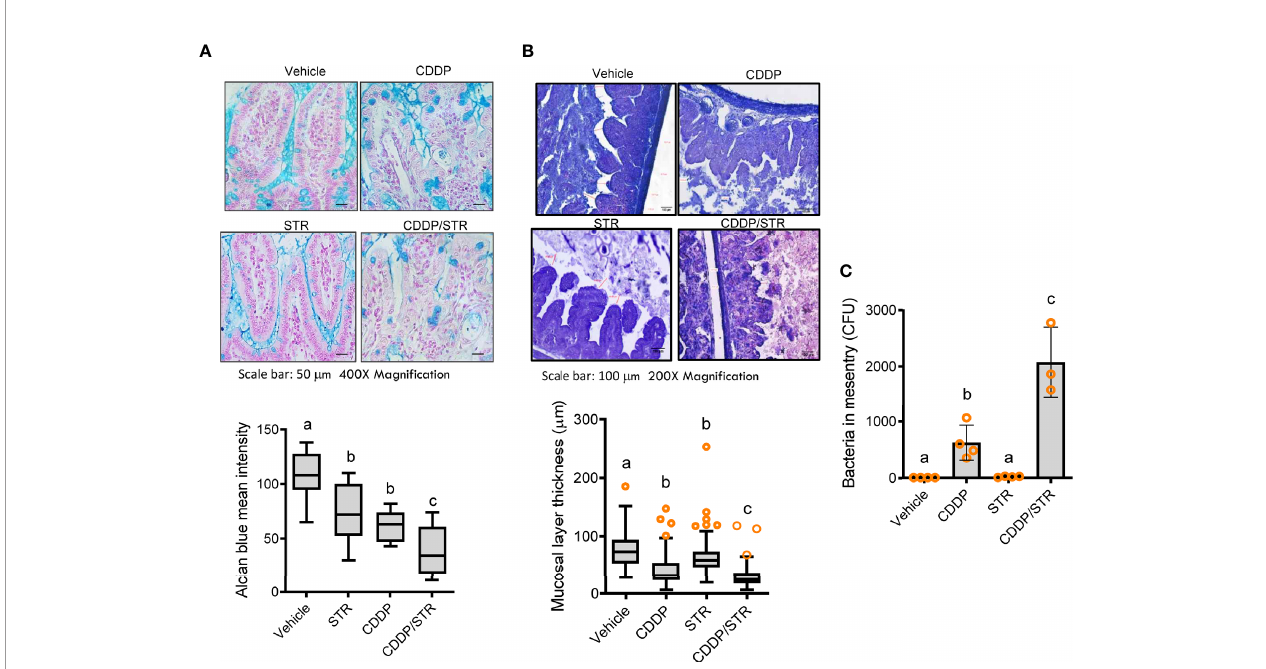
FIGURE 4 | Effects of STR exposure on the intestinal mucosal barrier in CDDP-induced renal injury model. Eight-week-old wild type male mice (n = 3 – 5) were orally preexposed to the vehicle or streptomycin (20 mg/mouse) for 24 h and then renal injury was induced with CDDP (20 mg/kg) via intraperitoneal administration for an additional 72 h. Results are representative of three independent experiments. (A) Secreted and intracellular mucins were stained with Alcian blue (blue colored, magni fi cation 400×, scale bar: 100 m m). Relative levels of the secreted mucin were measured (the lower graph). The results are shown as a plot with Tukey whiskers and the different letters (a – c) over each box represent signi fi cant differences between groups (p<0.05). (B) Representative images of the intestinal mucosa with Gram staining [magni fi cation 200×, scale bar(s) 100 m m]. The mucosal layer thickness was measured (the lower graph). The results are shown as a plot with Tukey whiskers and the different letters (a – c) over each box represent signi fi cant differences between groups (p<0.05). (C) The bacteria detected in the mesenteric lymph node (MLN) were quanti fi ed. The different letters represent signi fi cant differences between groups using ANOVA with Newman – Keuls method as a post hoc ANOVA assessment